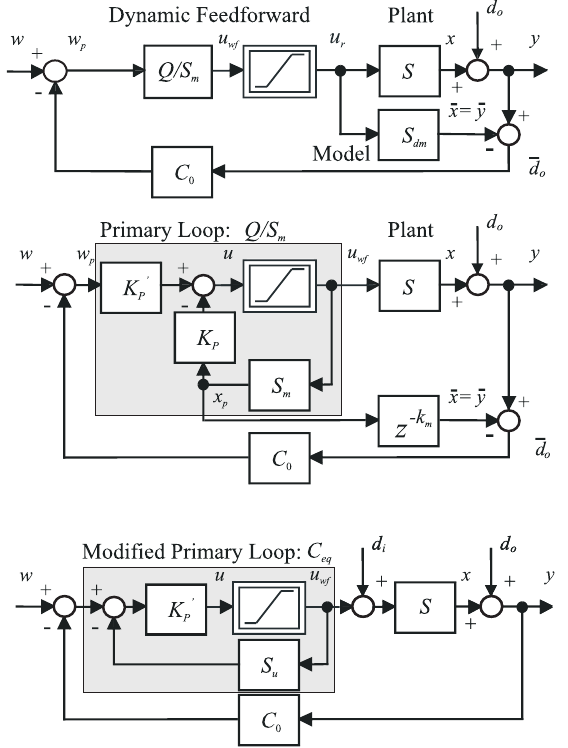
Figure 8. 2-DoF IMC as a setpoint feedforward with reconstruction and compensation of output disturbances d o ( above ), 2-DoF SP with a primary loop using 2-DoF P control ( middle ) and the equivalent structure with unchanged signals u and u wf of the saturation block, but eliminating the possibly unbounded output disturbance signal d o , which represent the key feature of the so-called filtered Smith predictor (FSP, below